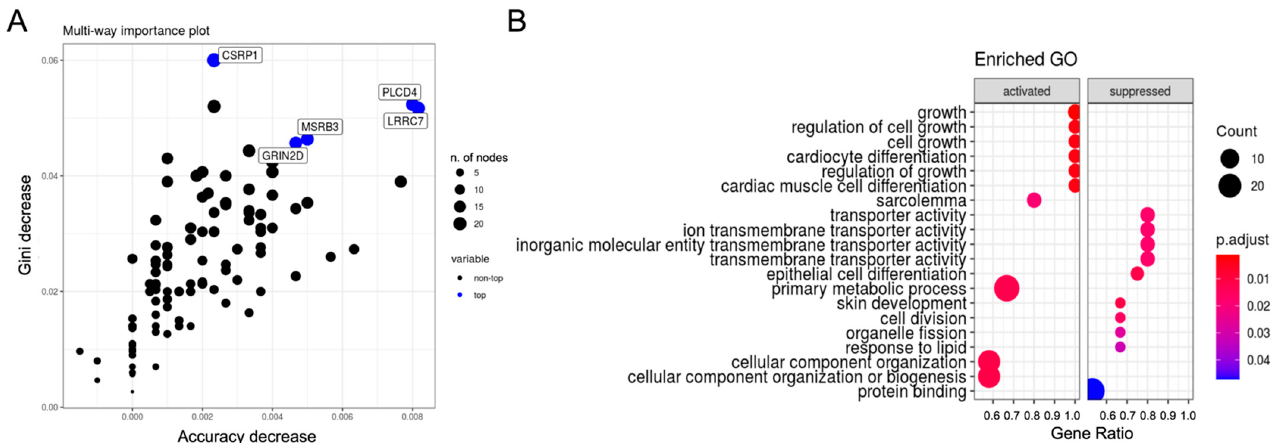
Figure 5. The most important genes in the classification analysis of sample groups, defined by circHIPK3 expression. ( A ) Variable importance plot of the most relevant genes used in the random forest model; ( B ) top 10 activated and suppressed enriched GO using most important genes in the group classification.